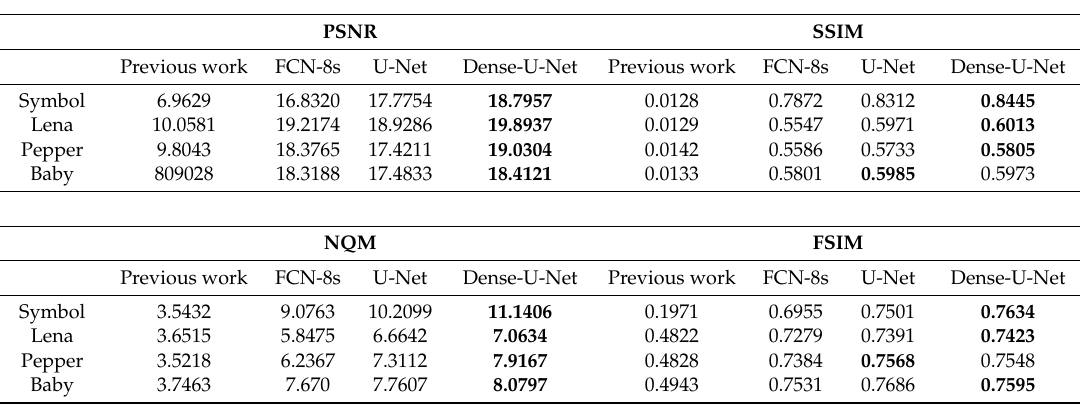
Table 1. Imaging quality evaluation parameters of output images produced by several methods. The best results are shown in